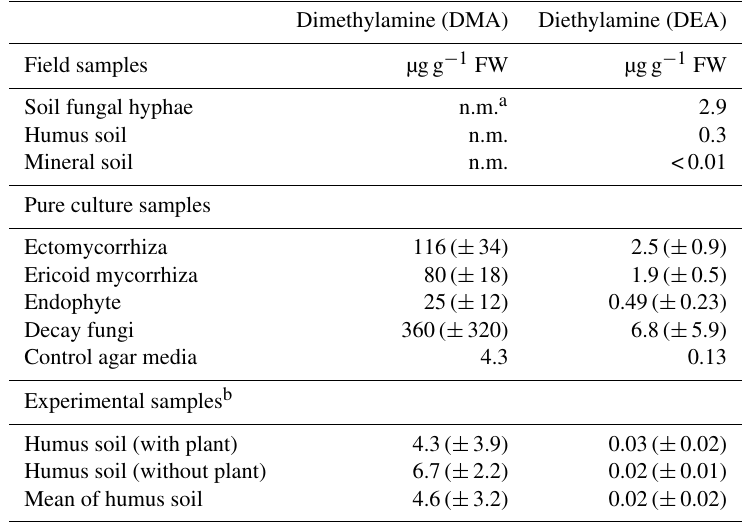
Table 1. The mean dimethylamine and diethylamine concentrations (µgg − 1 fresh weight) and their standard deviations in the field samples, different fungal functional groups, and in the humus soil in a greenhouse